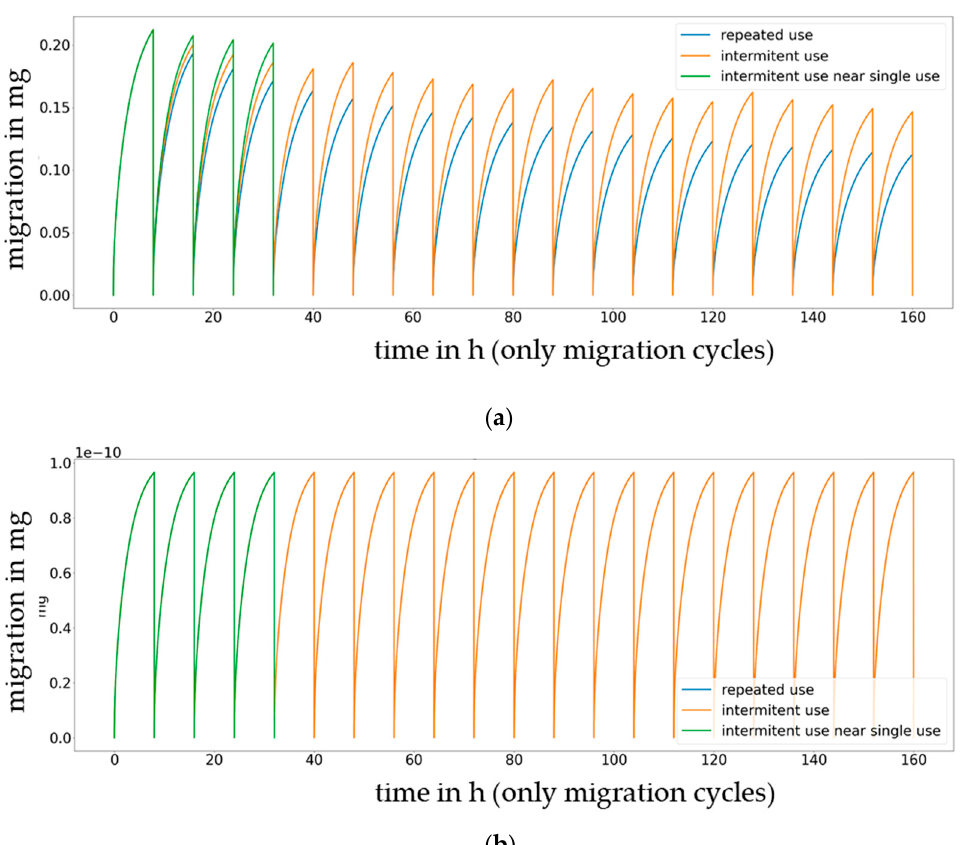
Figure 13. Cumulated migration of Metilox ( a ) and Irganox 1076 ( b ) to 50% ethanol at 60 °C by eliminating no-contact times (only migration cycles displayed, blue: continuous use, orange: intermittent use with 8 h contact and 16 h without contact and green: occasionally use).